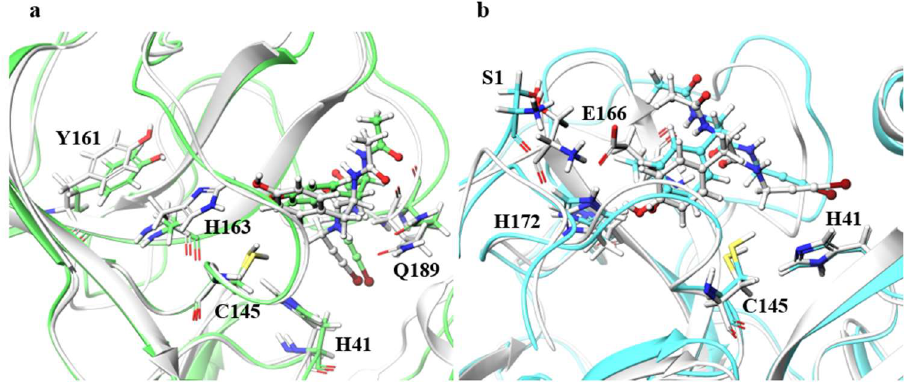
Figure 6. Structures around the ligand in the B chain. ( a ) Superimposition of the wild type and H163A around the ligand. Only the B chain is illustrated. Atoms and chains of wild type and H163A are presented in white and light green, respectively. The ligand is represented as a ball-and-stick model, and H41, C145, Y161, H163, and Q189 are represented by the stick model. ( b ) Superimposition of the wild type and E166A. Both A and B chains are illustrated. Atoms and chains of wild type and E166A are presented in white and cyan, respectively. Ligands are represented by the ball-and-stick models, and S1, H41, Cys145, E166, and H172 are represented by stick model. Of these residues, Only S1 belongs to the A chain, and the other residues belong to the B chain.